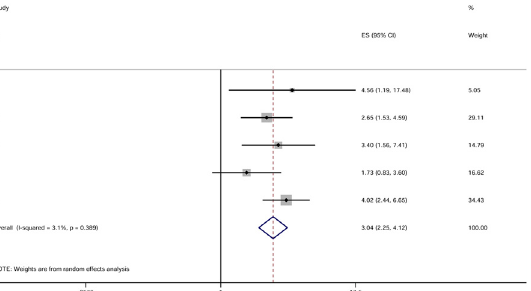
Fig 2. Results of the meta-analysis on pooled HR values. Each square denotes the HR for that trial comparison with the horizontal lines showing the 95% CIs. The size of the square is directly proportional to the amount of information contributed by the trial. The hollow blue diamond gives the pooled HR from the random effect model; the centre of this diamond denotes the HR and the extremities the 95%